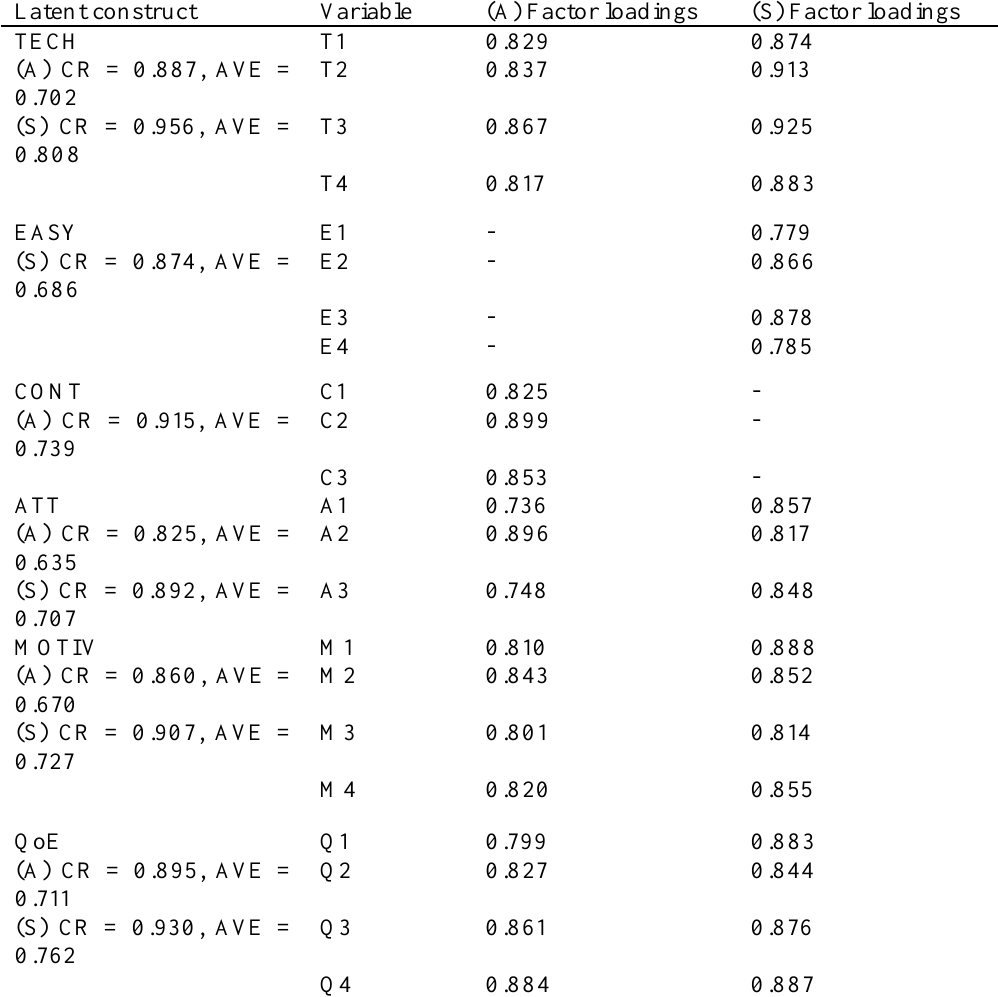
Table 2 Results from the Measurement Model during Asynchronous (A) and Synchronous (S) Learning